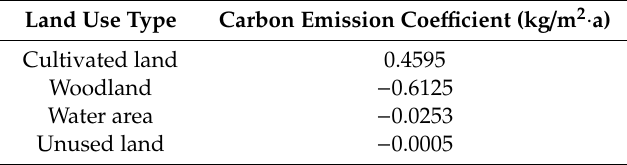
Table 1. Carbon emission or absorption coe ffi cients for di ff erent land use types.